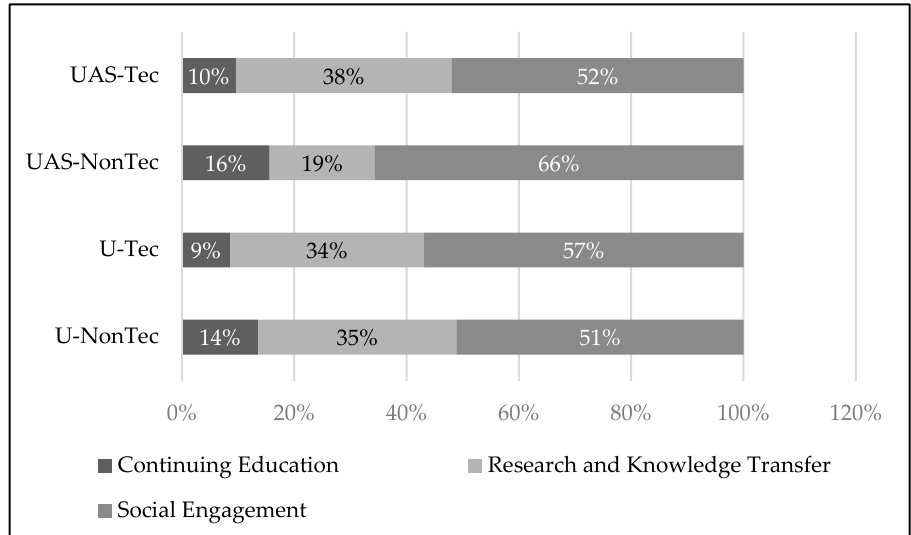
Figure 1. Third Mission profiles of the case study universities. Note: UAS = university of applied science, U = university, Tec = technical orientation, NonTec = non-technical orientation. UAS-Tec N = 52, UAS-NonTec N = 31, U-Tec N = 58, U-NonTec N = 88. The data collection reflects the situation as of July 2016.